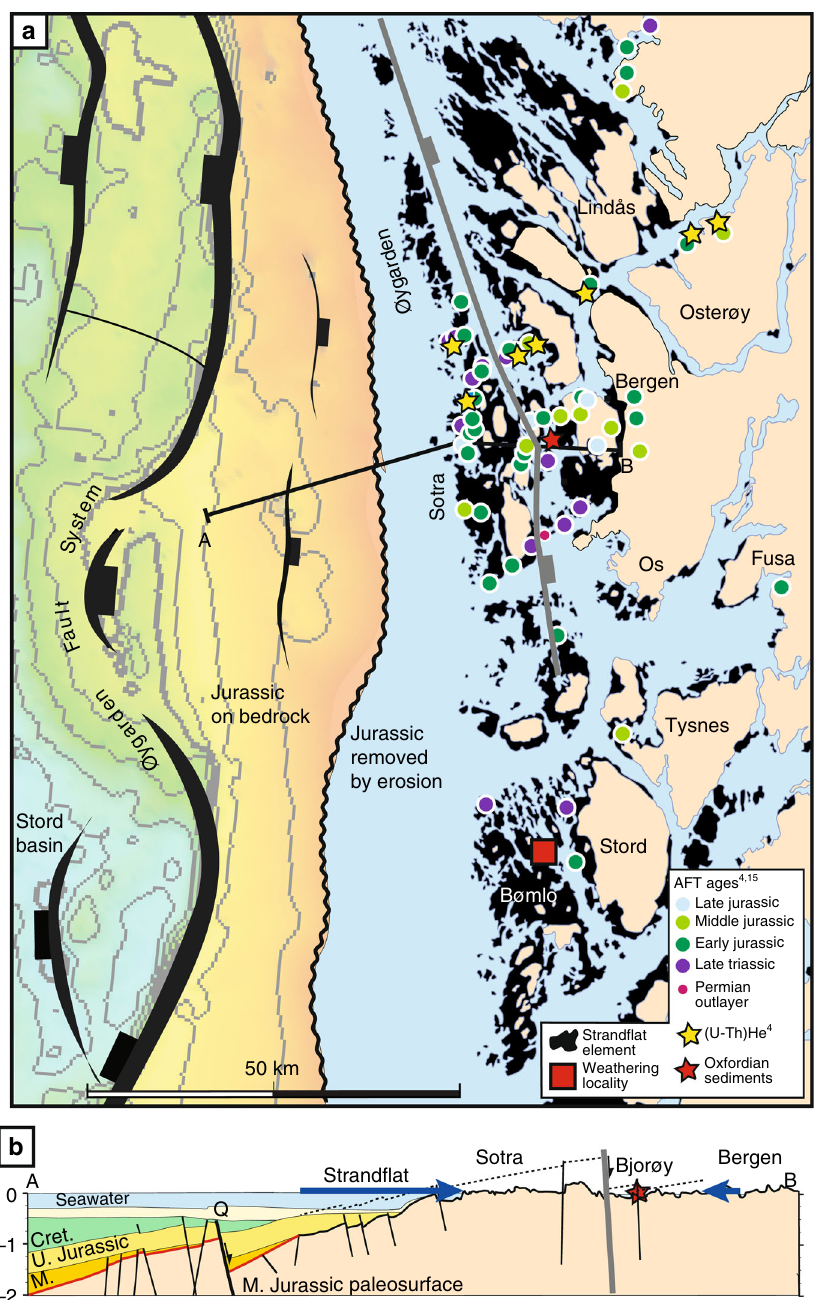
Fig. 1 Map of and cross-section through the strand fl at. a Map of the strand fl at area in SW Norway, and offshore fault and top basement map. The erosion line marks the eastern boundary of Jurassic sediments on basement. Red square marks sampling locality by Fredin et al. 1 (Bømlo). AFT localities (from Ksienzyk et al. 4 and Kohlman et al. 15 ) are color-coded with respect to age. b Cross-section 2 , showing the west-dipping Jurassic paleosurface buried under Middle and Late Jurassic sediments and cut by the strand fl at near sea